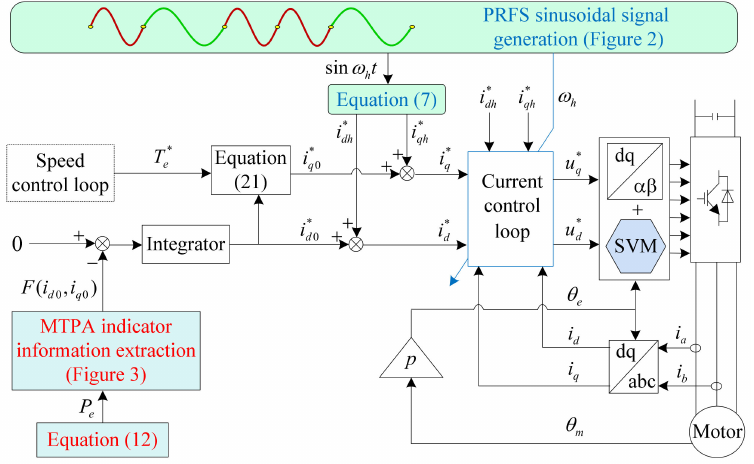
Figure 4. Block diagram of the proposed MTPA control scheme based on PRFS signal injection. In Figure 4, the reference of the dc component of the q -axis current (namely, i ∗ generated based on Equation (21), where the motor parameters L d , L q , and ψ f can be assumed as their nominal values. The generation of the reference i ∗ i ∗ and Equation (21), and hence, although inaccurate motor parameters are employed q 0 in Equation (21), the accuracy of the MTPA point tracking will not be affected [14]. The adoption of inaccurate motor parameters in Equation (21) may result in torque error, which can be automatically compensated by the speed control